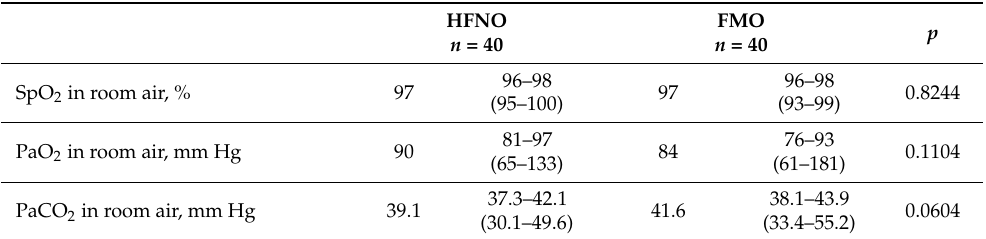
Table 2. Baseline oxygen saturation and arterial blood gas data, intravenous anesthetic agents, and intubation